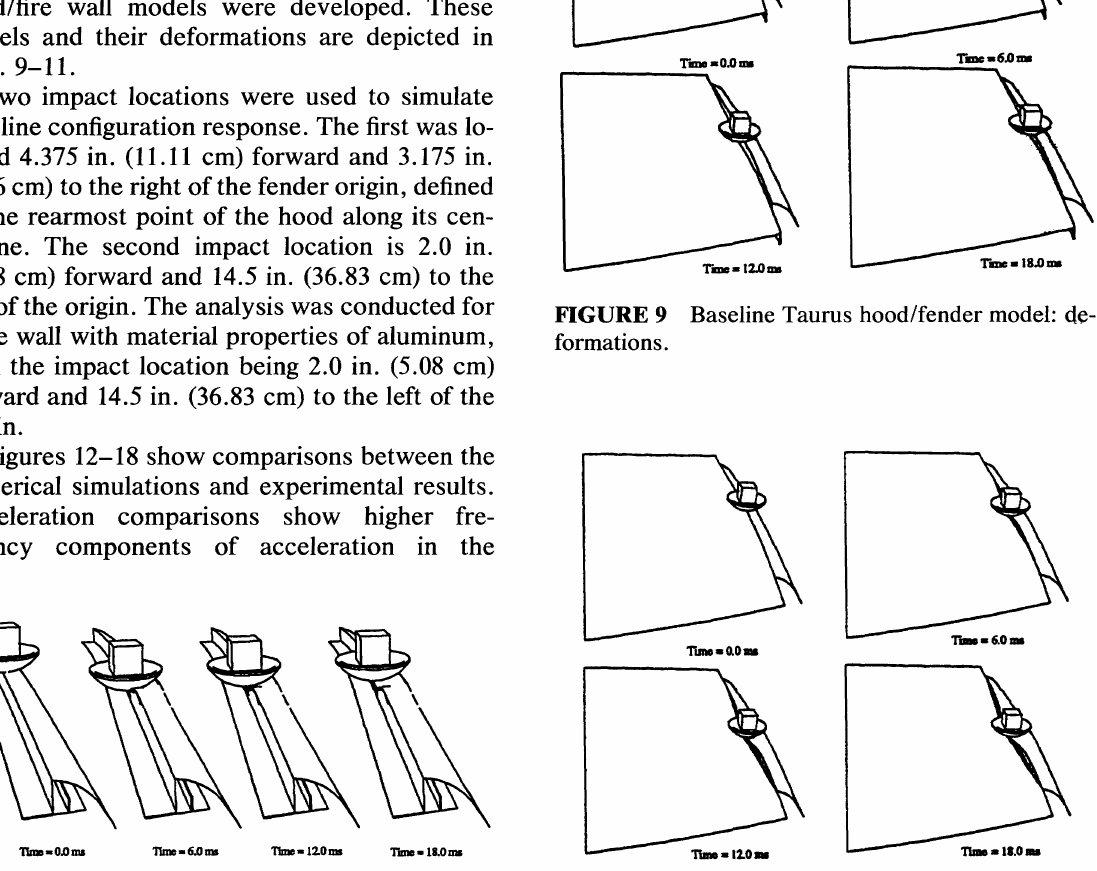
FIGURE 8 Modified Taurus fender model: deforma tions.